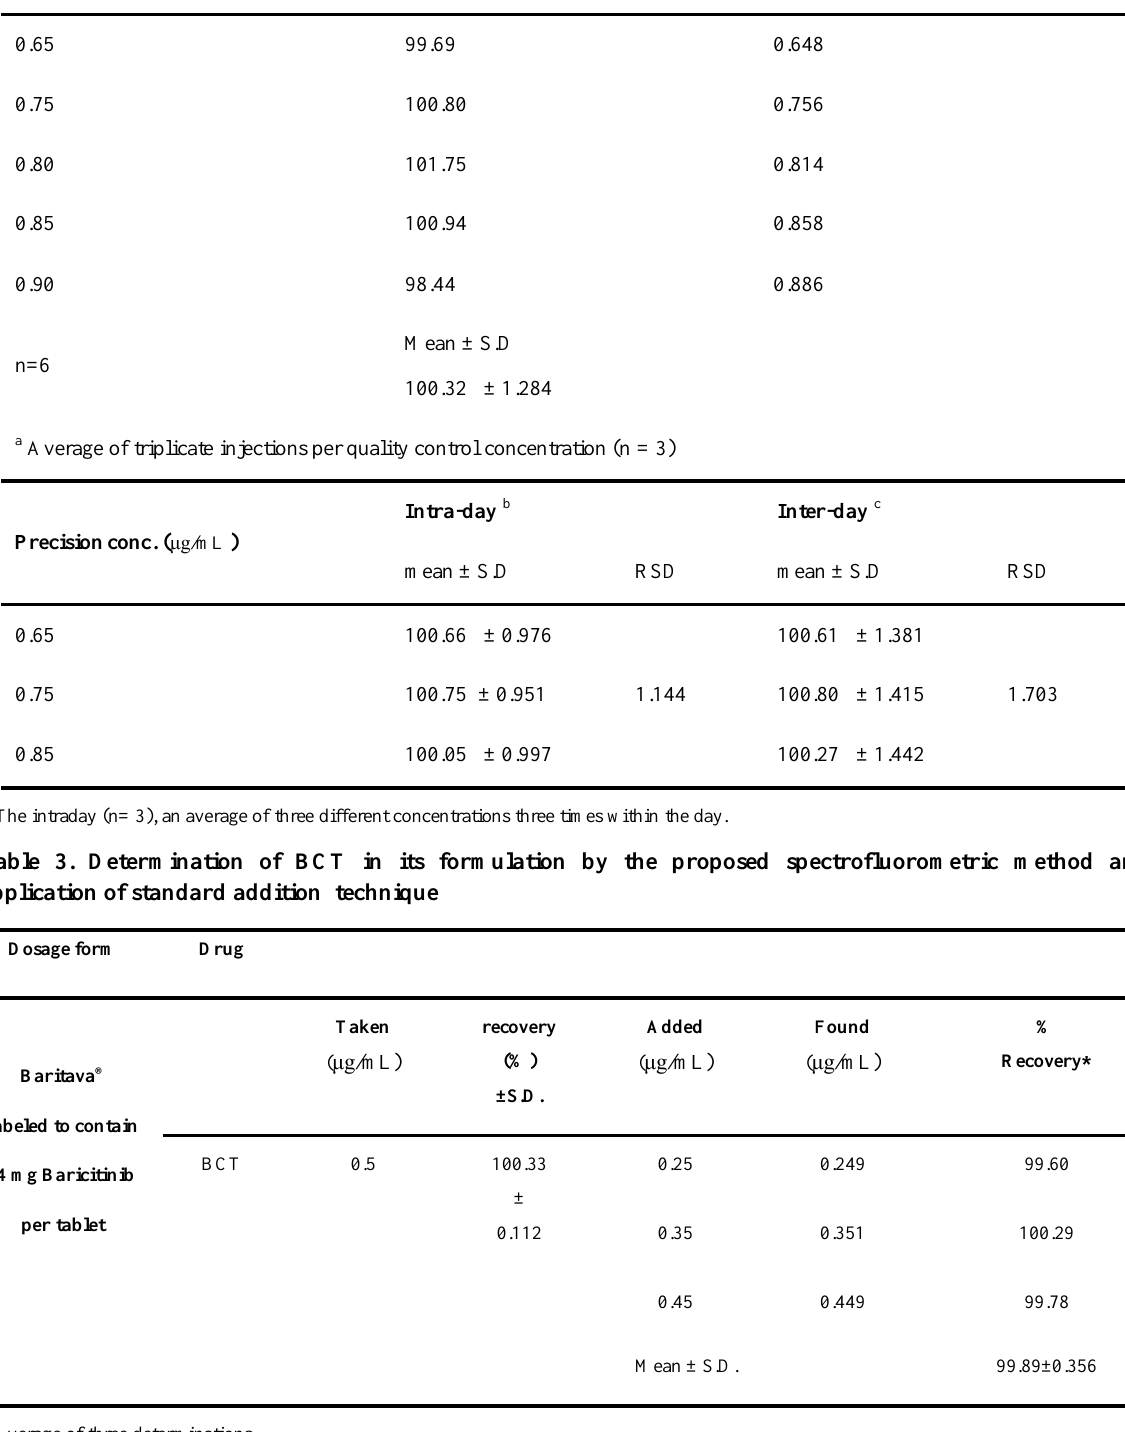
Table 2. Accuracy and precision results for the determination of BCT using the proposed method Accuracy a conc. (μg/mL)